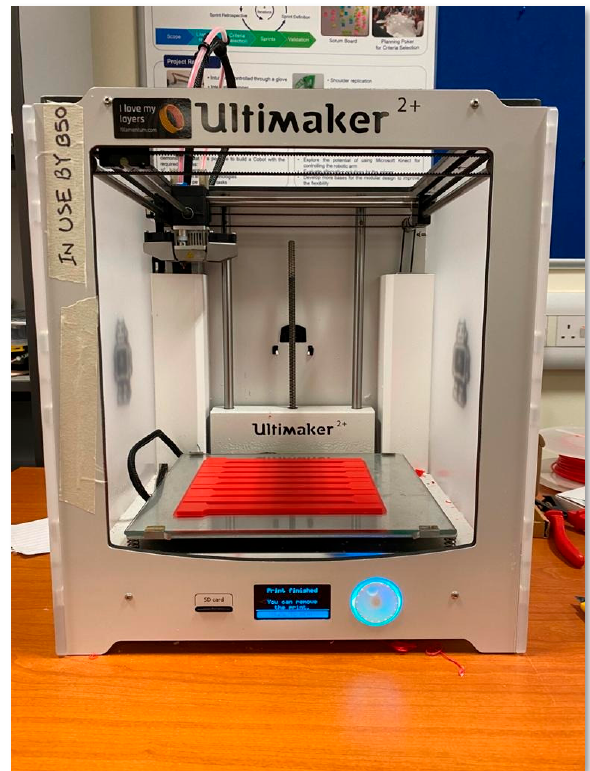
Figure 5. The 3D printing process by the Ultimaker 2+ printer.